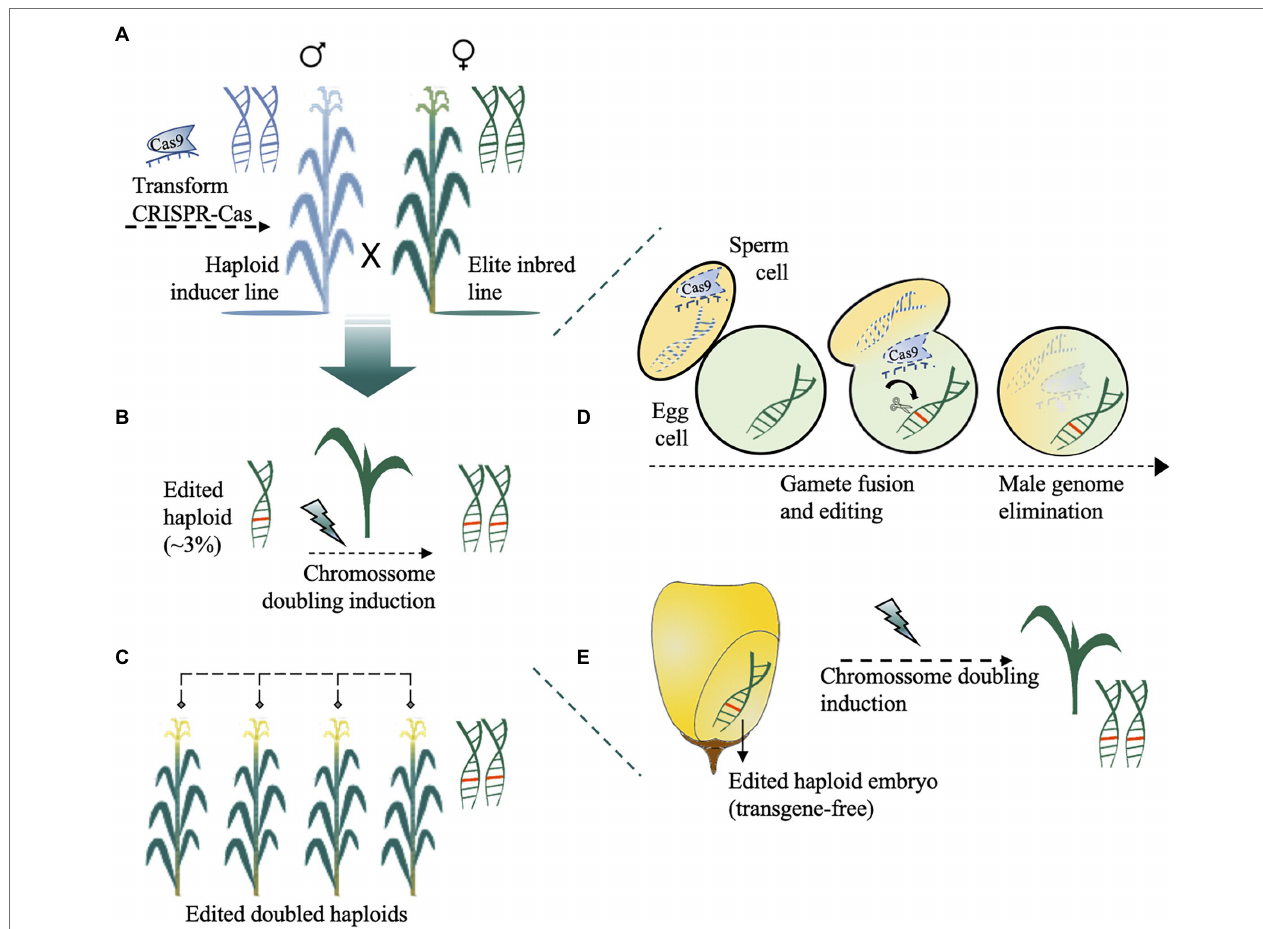
FIGURE 4 | Haploid-inducer-mediated genome editing (IMGE) or simultaneous double haploid production and editing (HI-Edit) in maize. (A) The haploid inducer line harbouring a CRISPR-Cas cassette is used to pollinate the maternal elite line of any genotype. (B) The haploid progeny, which are typically sterile, were screened for CRISPR-Cas-induced mutations (~3%) and subsequently treated with a doubling agent to produce fertile doubled haploids. (C) Edited doubled haploid lines with improved agronomic traits are obtained after self-pollination. The zoomed view of trans genome editing and the maternal haploid formation processes occurring in B are shown in D-E. (D) After trans-acting CRISPR-Cas, and fertilization, the unstable paternal chromosome from haploid-inducer pollen is lost. (E) The formed embryo is nontransgenic (Cas-free) and has a doubled chromosome to recover the homozygous edited diploid elite